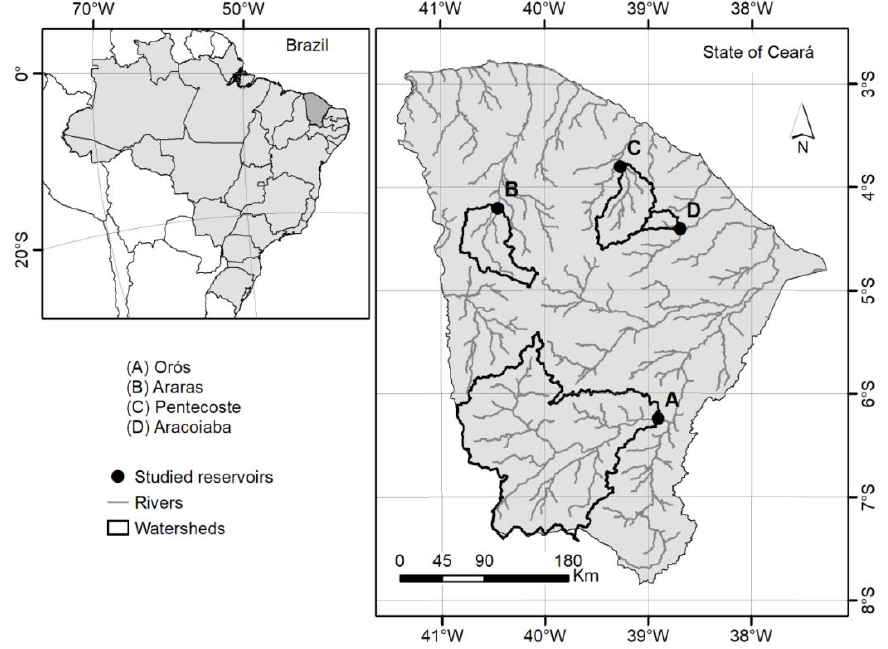
Figure 1. Location of the State of Ceará, Brazil, the study reservoirs, and their respective catchment